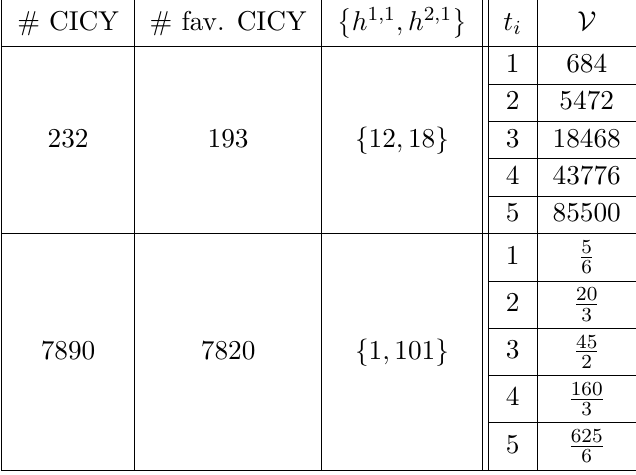
Table 12 . Estimates for the maximum and minimum values of the CY volumes ( V ) among the Kähler positive CICYs for different values of t i